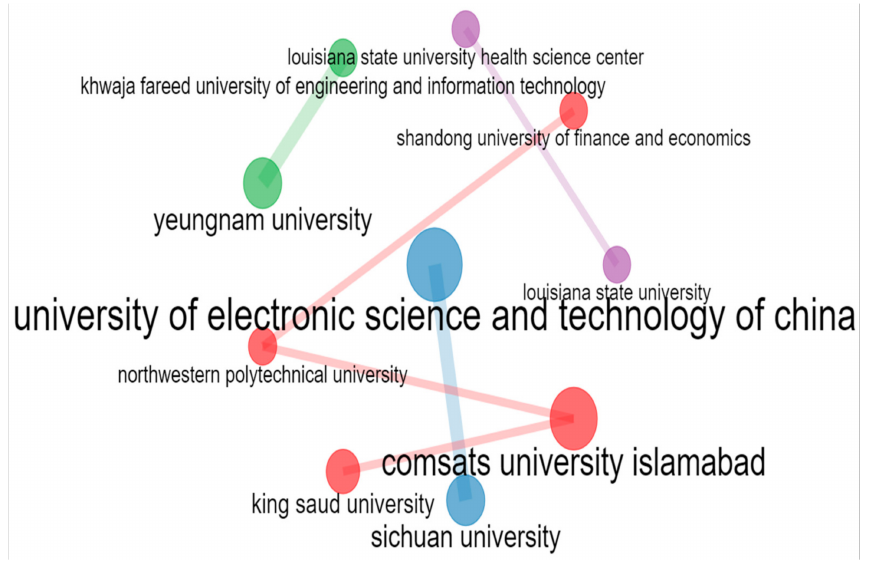
Figure 24. Co-authorship relationships among